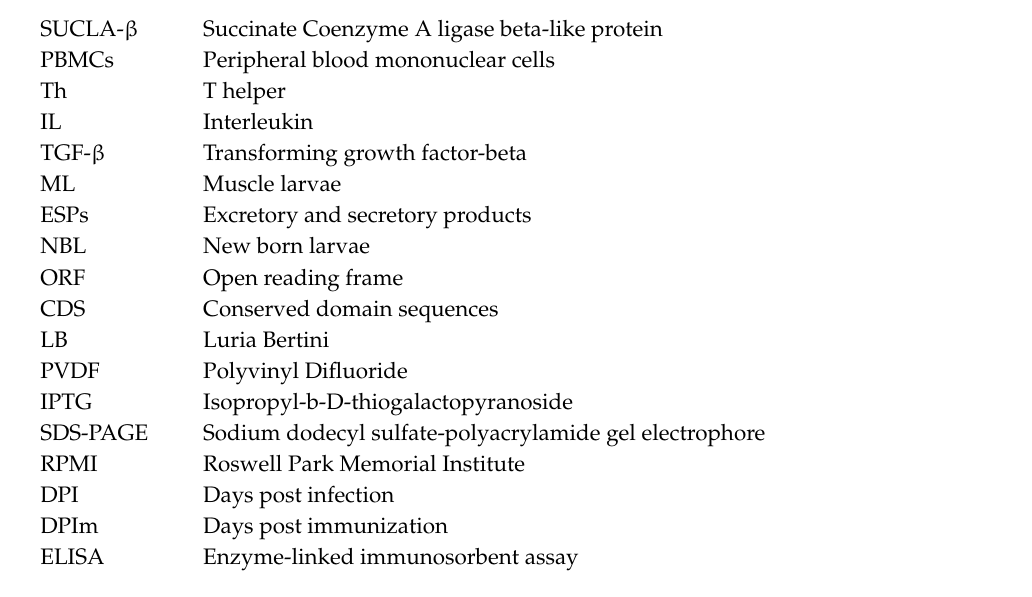
Figure S1: Cloning of SUCLA- β gene and identification of the recombinant plasmid (pET-32a ( + ) Ts-SUCLA- β ); Figure S2: Membrane protein prediction and N-terminal signal peptide prediction of Ts-SUCLA- β